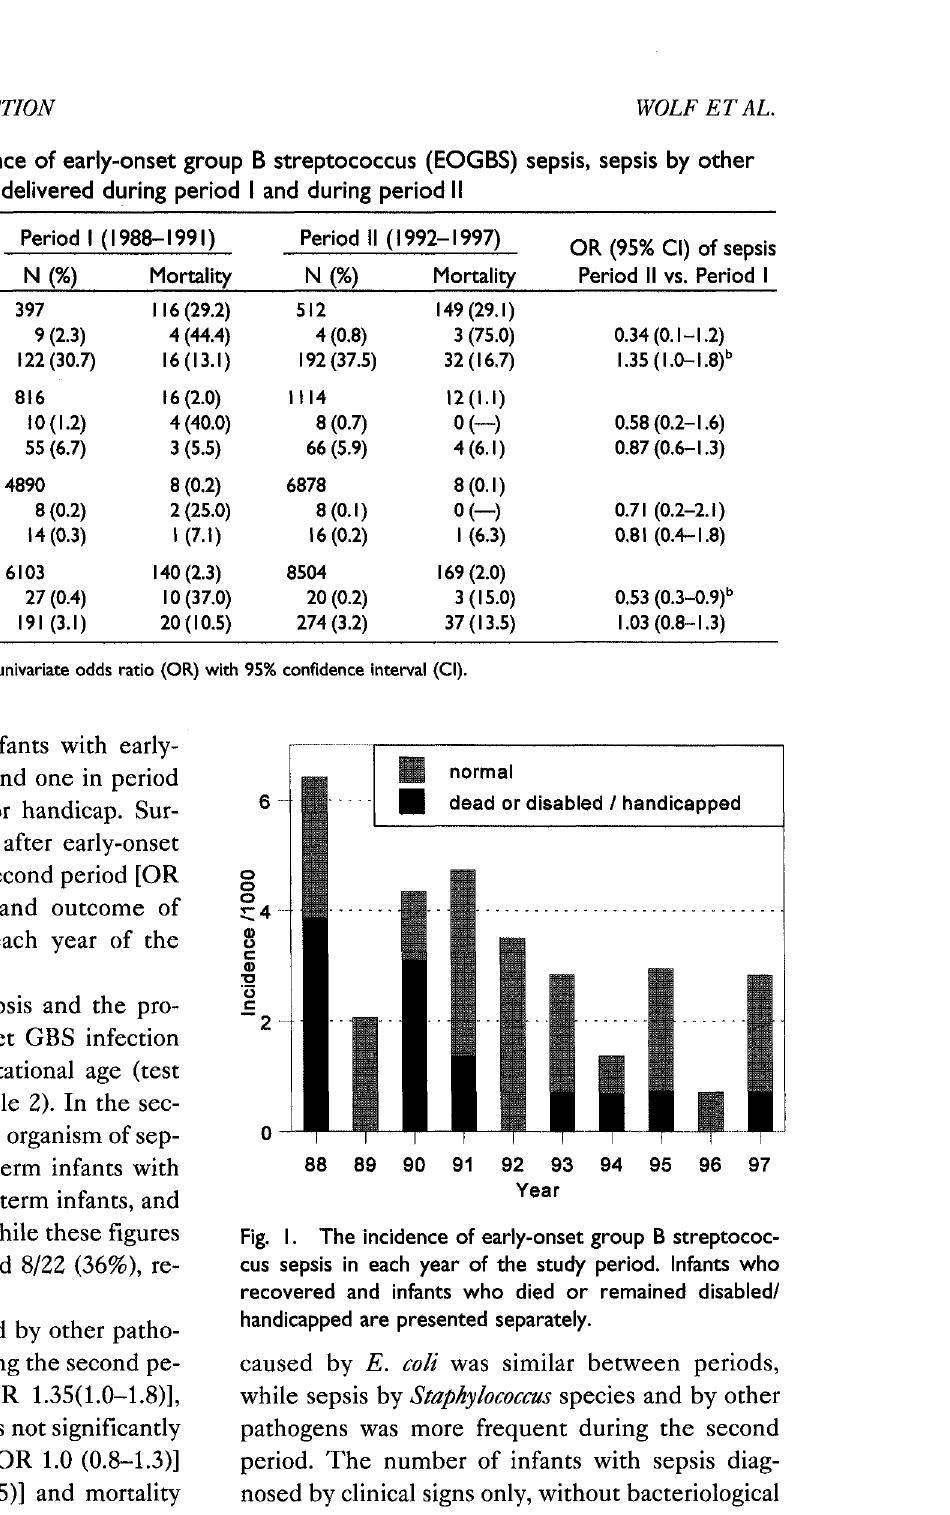
Table 3 subdivides all infants with sepsis for different pathogens. The incidence of sepsis